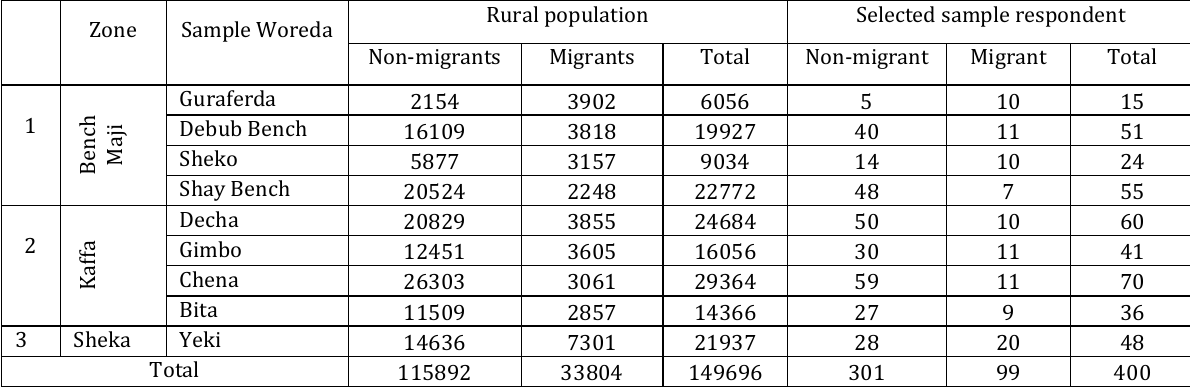
Table 1. Sample of rural households (Source: Own survey, 2019)